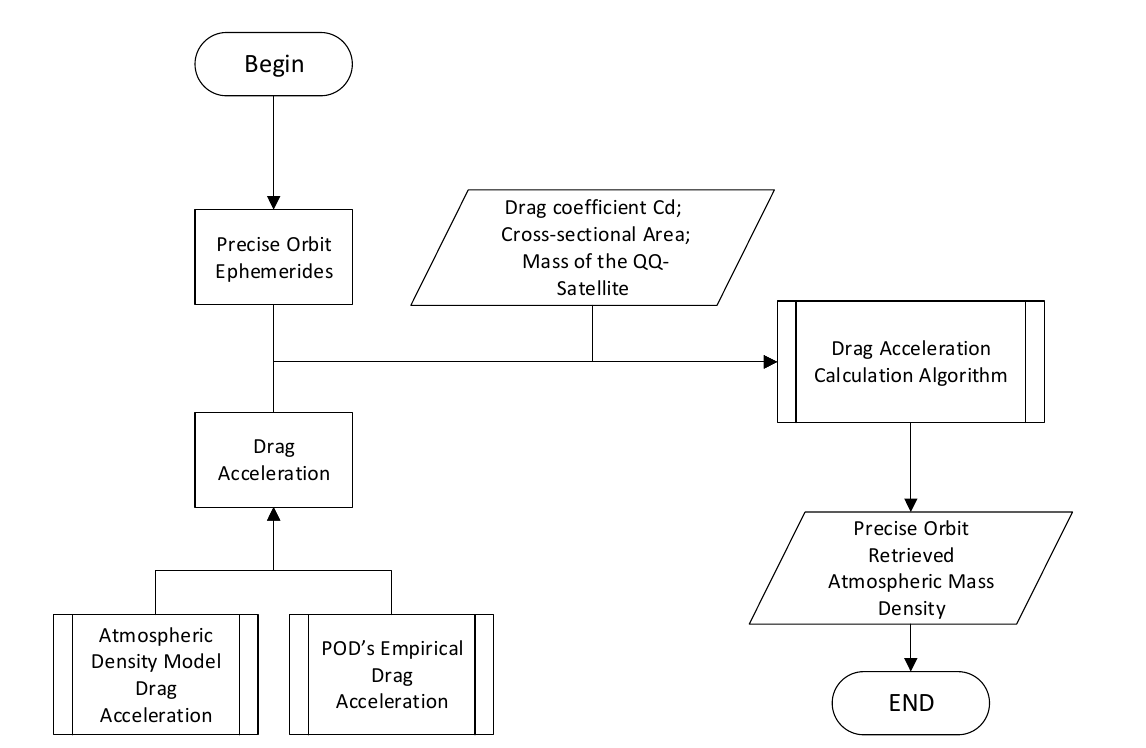
Figure 4. The method for retrieving densities from precise orbits.